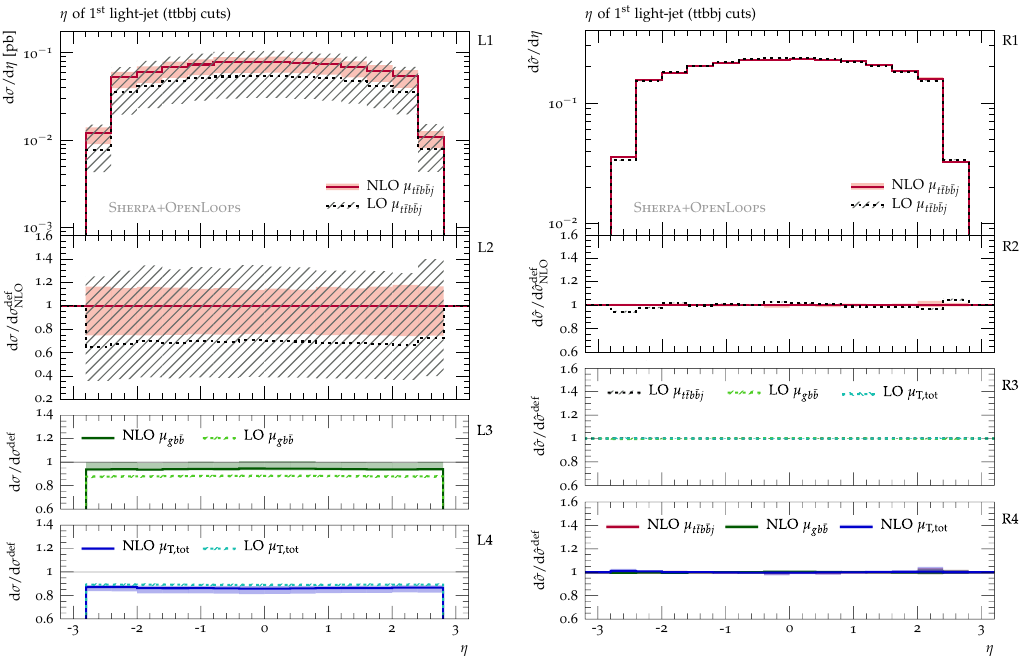
Figure 9. Pseudo-rapidity of the leading light jet. Same setup and plots as in (cid:12)gure 8.